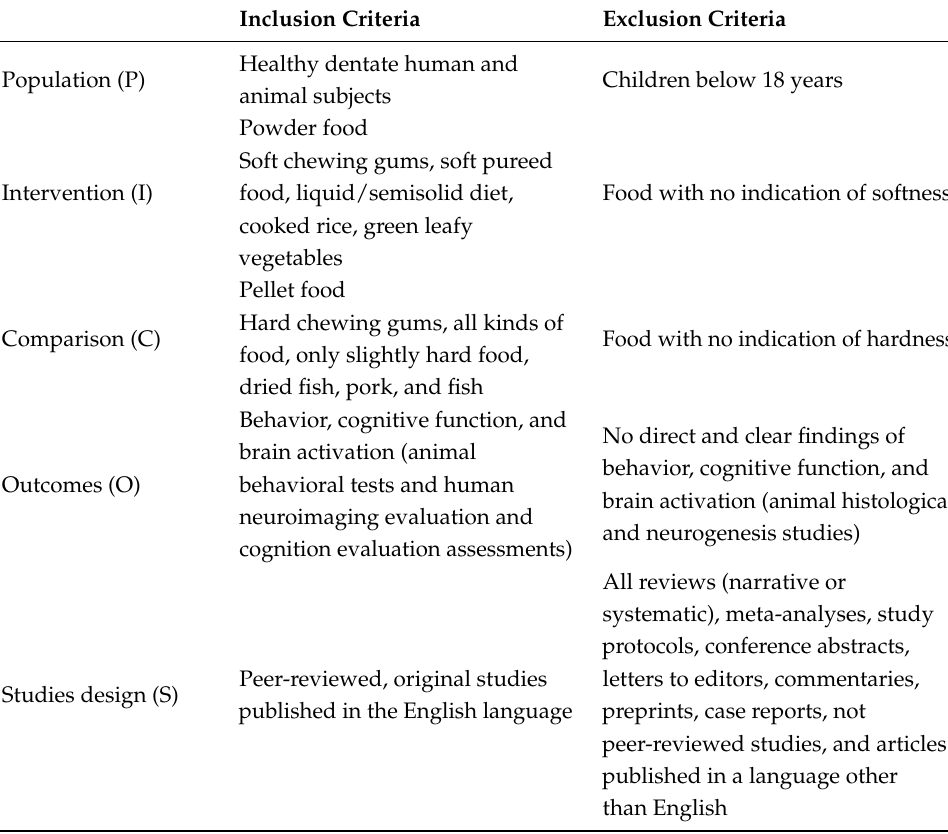
Table 1. PICOs criteria for inclusion and exclusion of